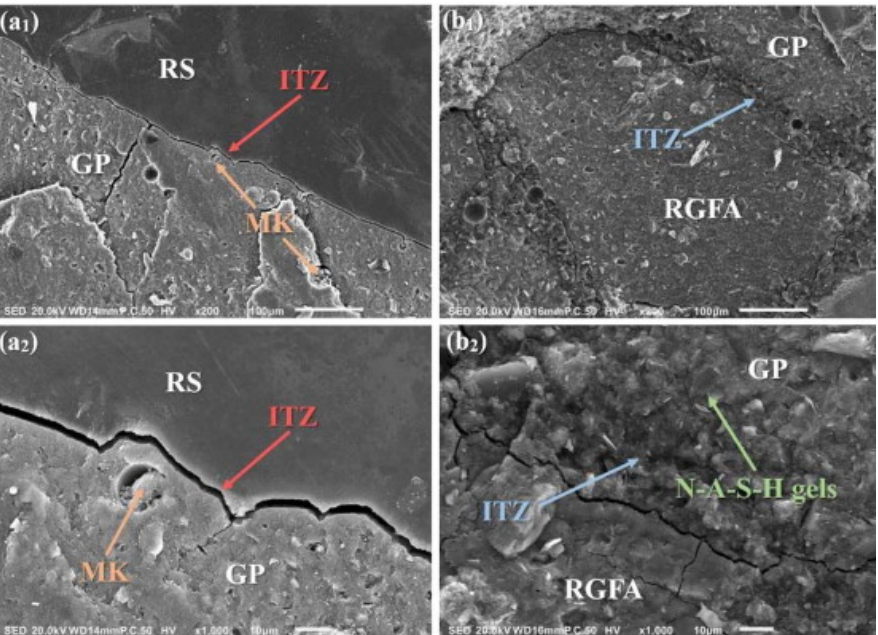
Figure 11. SEM investigation of different ITZs: Microstructural effects of RS and RGA (reproduced with permission from Zhu et al., Construction and Building Materials ; Elsevier, 2020).